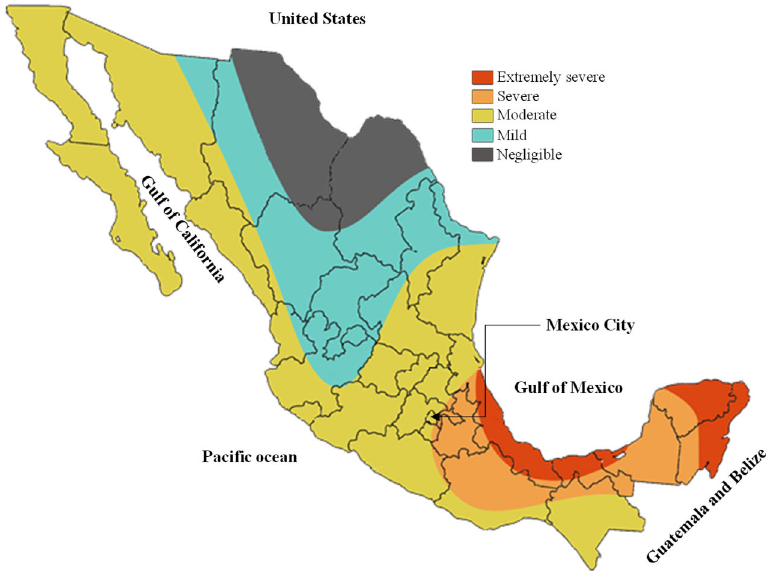
Figure 1. Environmental aggressiveness [10,11].